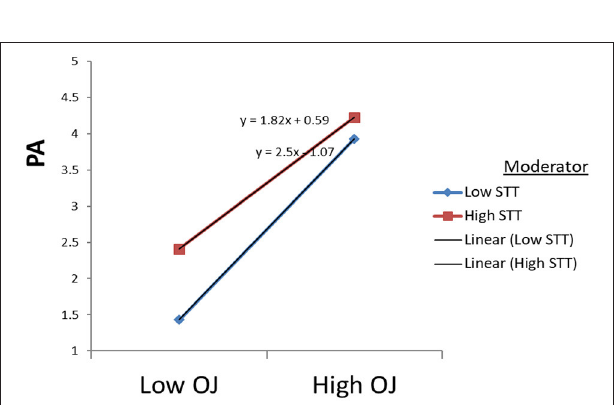
FIGURE 5 | Moderating effects of STT on PA through